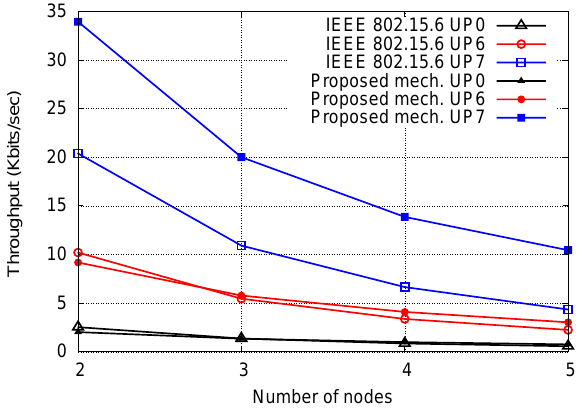
Figure 3. Throughput comparison of IEEE 802.15.6 and proposed mechanism for different